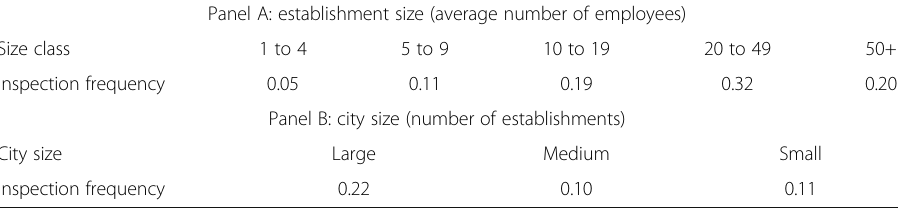
Table 6 Inspection intensity, by average plant and city size Panel A: establishment size (average number of employees)